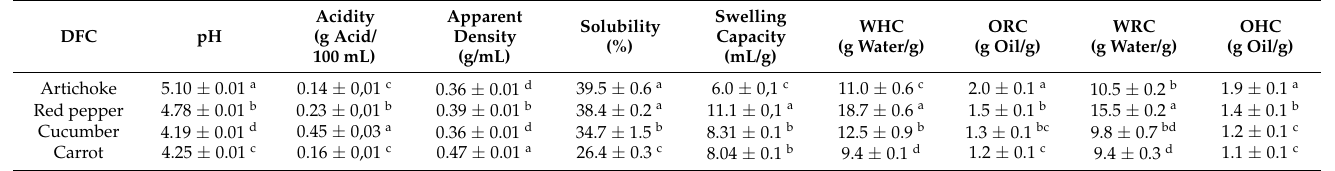
Table 2. Physicochemical properties of vegetable dietary fibre concentrates